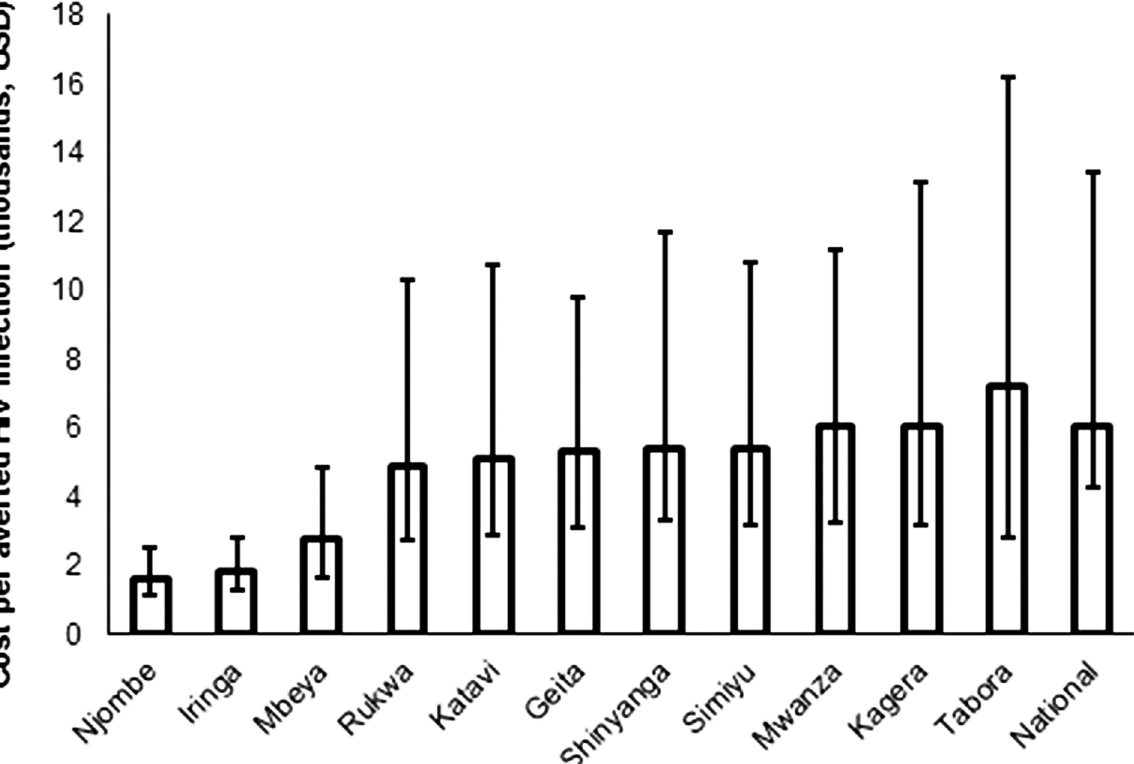
Fig 4. Discounted cost per HIV infection averted by region, 2014 – 2028, given a scenario of scale-up to 80% of 10- to 34-year- olds.